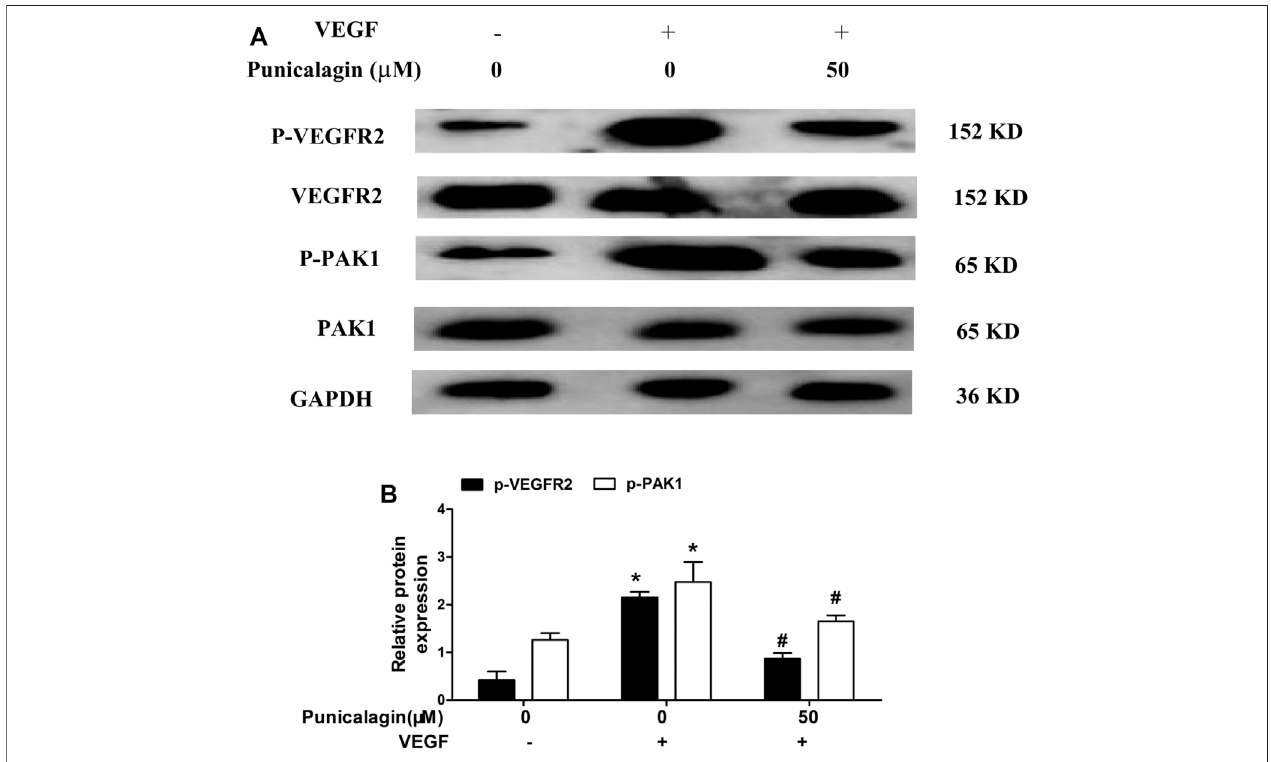
FIGURE 10 | Inhibitory effect of punicalagin on VEGF-induced phosphorylation of VEGFR2 and PAK1. (A) Protein expression levels of phospho-VEGFR2 and phospho-PAK1 normalized by GAPDH. (B) The densitometric analysis of phospho-VEGFR2 and phospho-PAK1 * p < 0.05, VEGF treatment versus control group, # p < 0.05 TNF- α + punicalagin treatment vs. treatment with VEGF